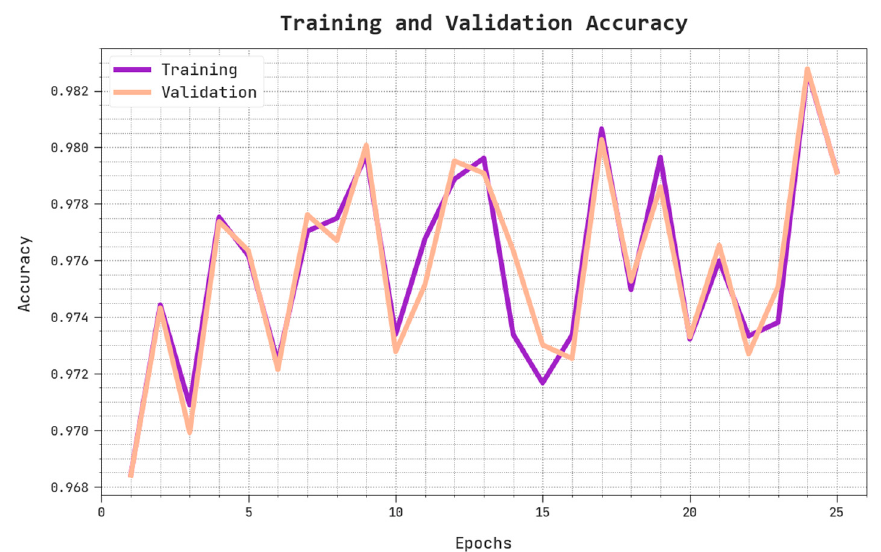
Figure 6. TACC and VACC analysis of IMFL-IDSCS system.